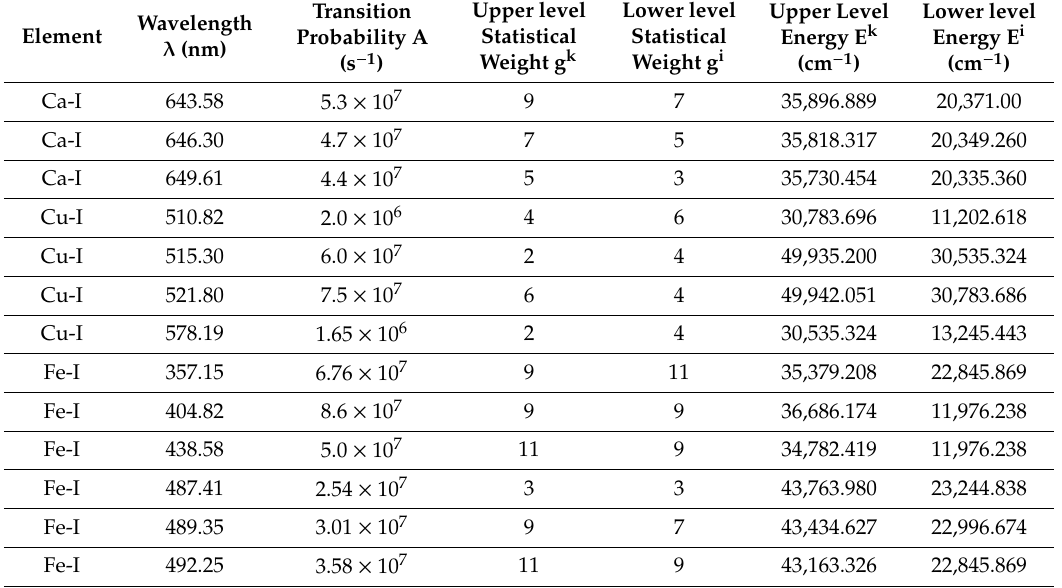
Table 2. Optical parameters of chosen emission lines of di ff erent compositional elements of Chalcopyrite sample used for calibration free